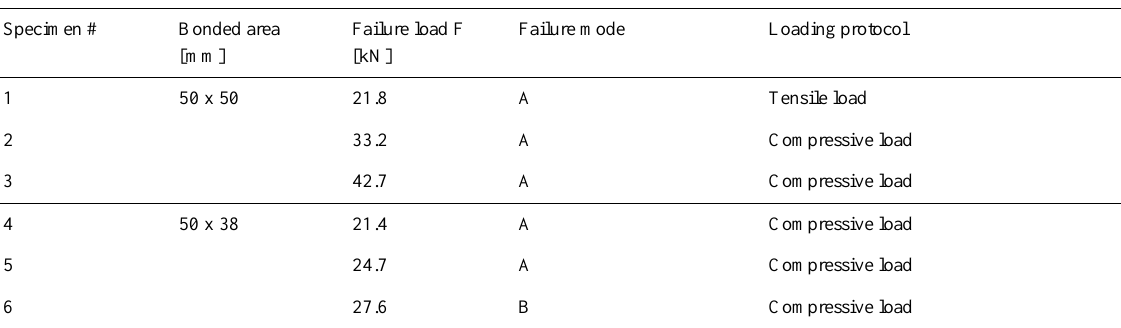
Table 1: Summary of past experimental test results on glass-steel acrylate shear connections (Pravdová et al., 2016). Key: A= glass rupture, B= adhesive/cohesive failure